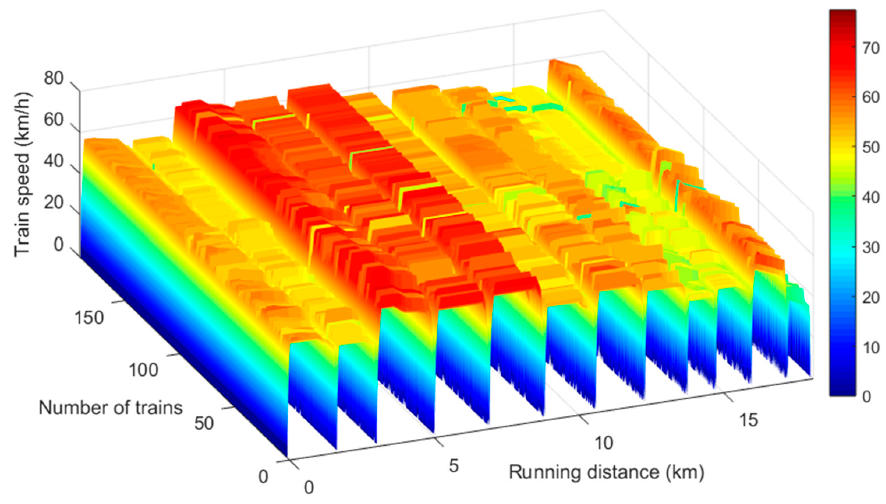
Figure 9. BFO-based optimized speed-distance profiles of all planned trains listed in the weekend timetable. Direction: SiHui (SH) – TuQiao (TQ).